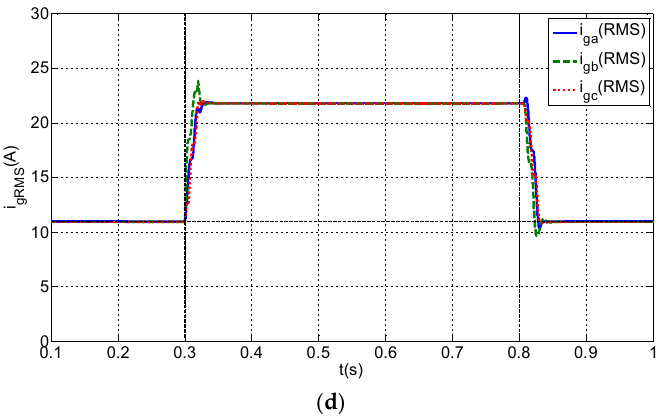
Figure 24. Dynamic simulation waveform of unbalanced load compensation: ( a ) Three-phase unbalanced load current; ( b ) The output current of the SPC device; ( c ) Grid current after compensation; ( d ) RMS of grid current after compensation.